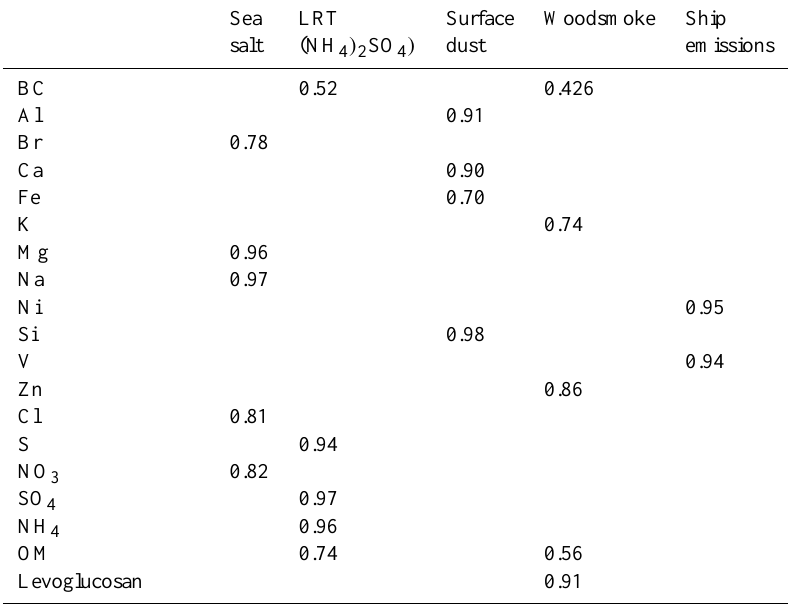
Table 2. Principal component analysis of the PM 2 . 5 chemical species.